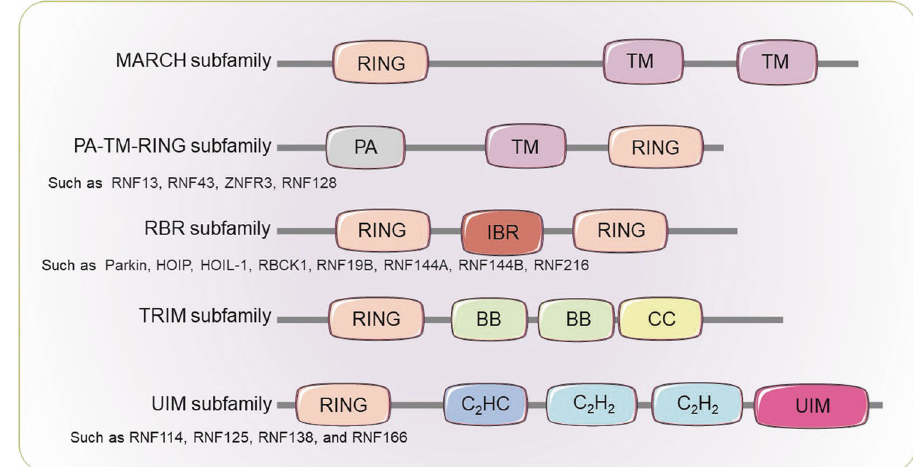
Fig. 1 Classi fi cation of the RING fi nger (RNF) family. All members of the RNF family are characterized by the N-terminal RING domain. Each subfamily has its unique domains besides the conserved RING domain. The MARCH subfamily is characterized by the TM domain. The PA-TM- RING subfamily is characterized by the PA domain and two TM domains. The RBR subfamily is characterized by the IBR domain. The TRIM subfamily is characterized by two BB domains and a CC domain. The UIM subfamily is characterized by a C2HC-type zinc fi nger, two C2H2-type zinc fi ngers, and